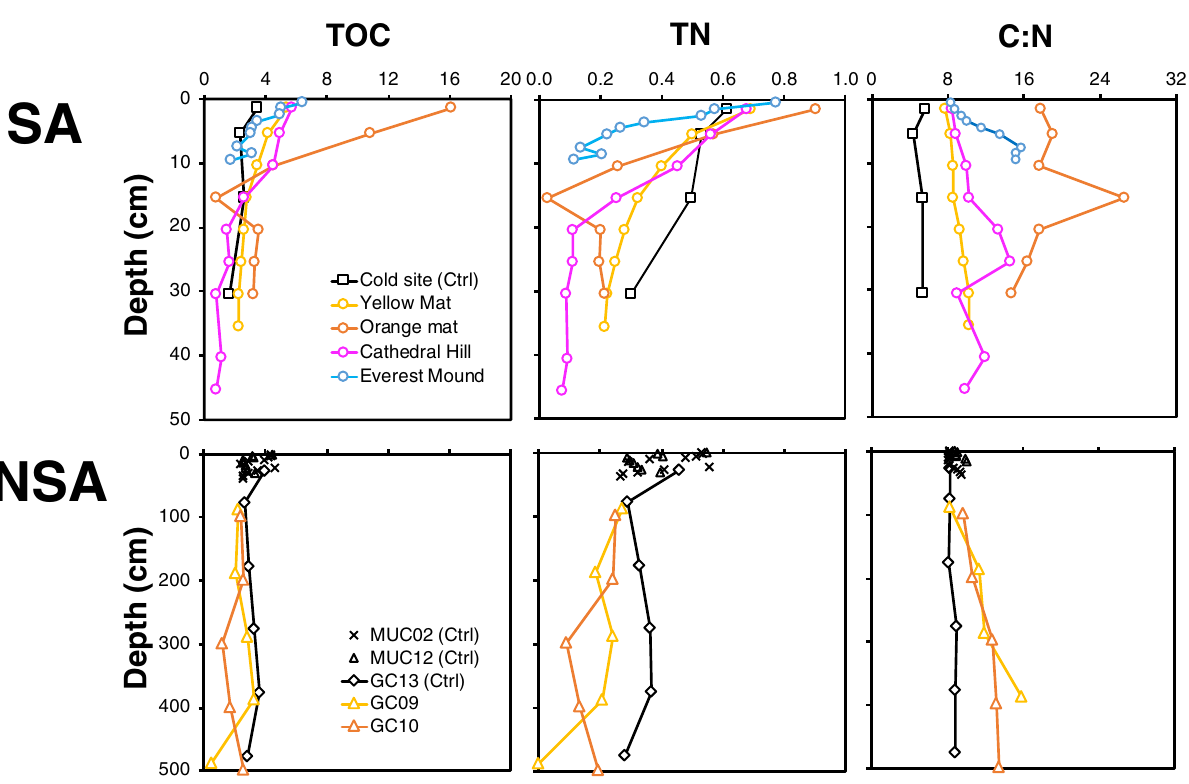
Fig. 3 Carbon and nitrogen contents of bulk organic matter. Depth pro fi les of total organic carbon (TOC), total nitrogen (TN), and TOC:TN (C:N) across all